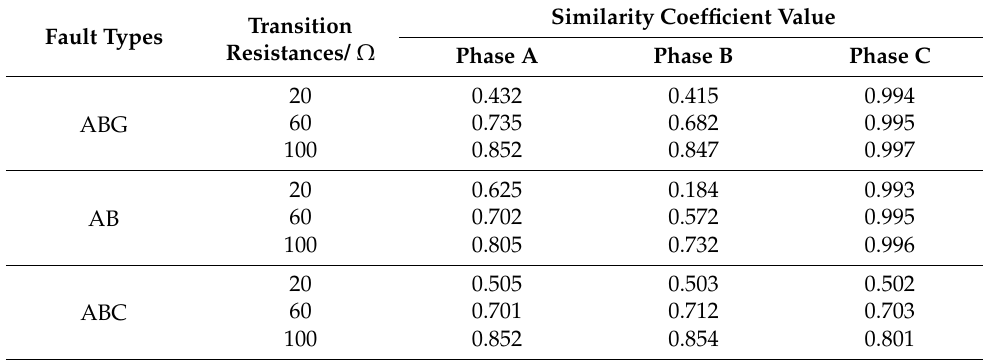
Table 2. Similarity coefficient under different fault types and transition resistances.